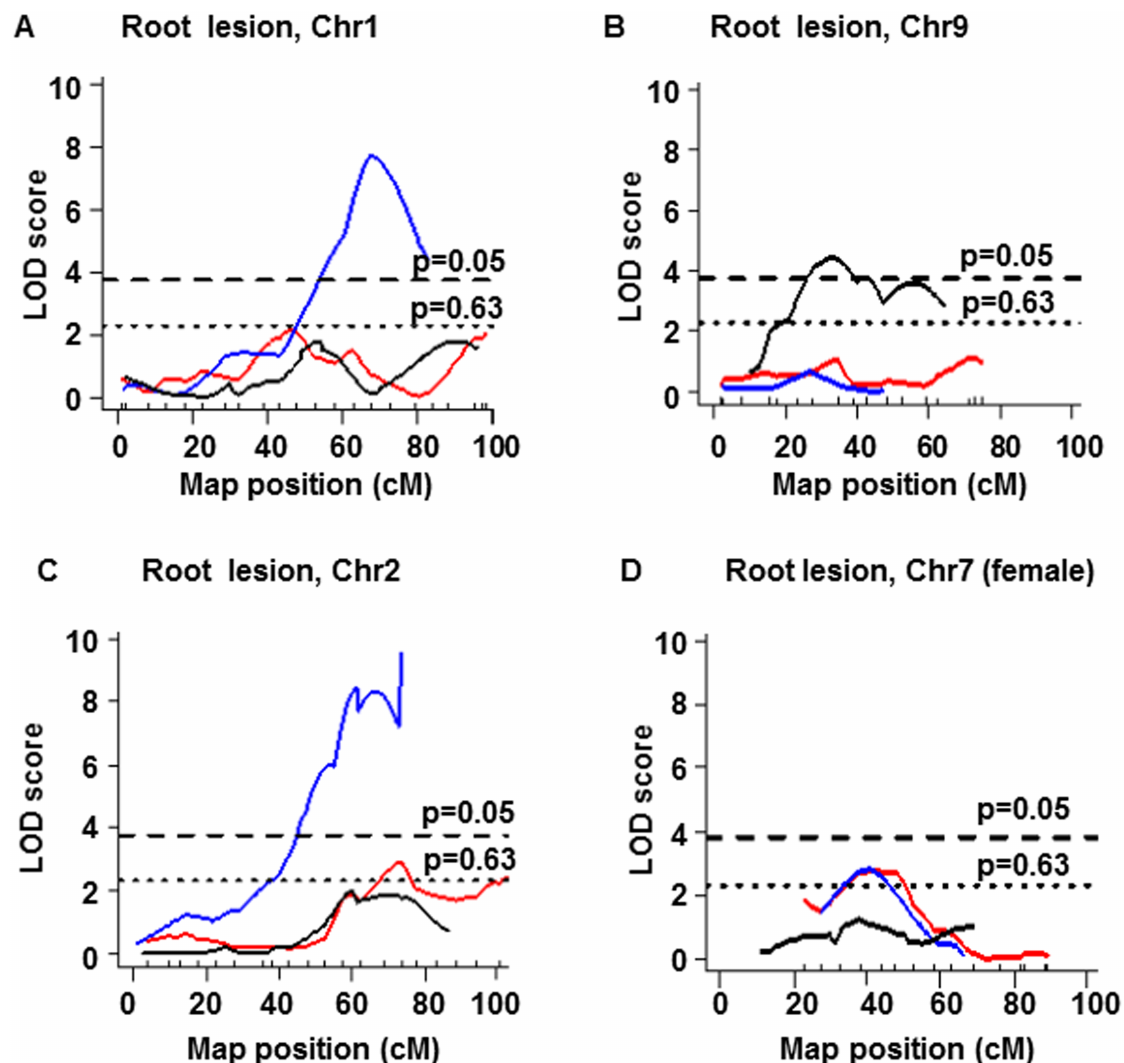
Fig 4. LOD curves of QTLs for plaque lesion size at root. (A-D) LOD curves of QTL for plaquelesion size at root in sex- combined(A,B, C) scans on Chr1 (A), Chr9 (B), Chr2 (C) and female-only (D) scan on Chr7 (D) cross between B6-apoEand DBA- apoE (red lines), cross betweenB6-apoEand 129-apoEmice (black lines) and cross betweenDBA-apoEand 129-apoEmice (blue lines). The horizontaldashedand dotted lines represent thresholds for suggestiveQTL (p = 0.63) and significantQTL (p = 0.05) determined in single locus scan of crosses betweenB6-apoEx DBA-apoEmice. The significancethresholdsfor LOD scores were determined by 1000 permutations using R/qtl